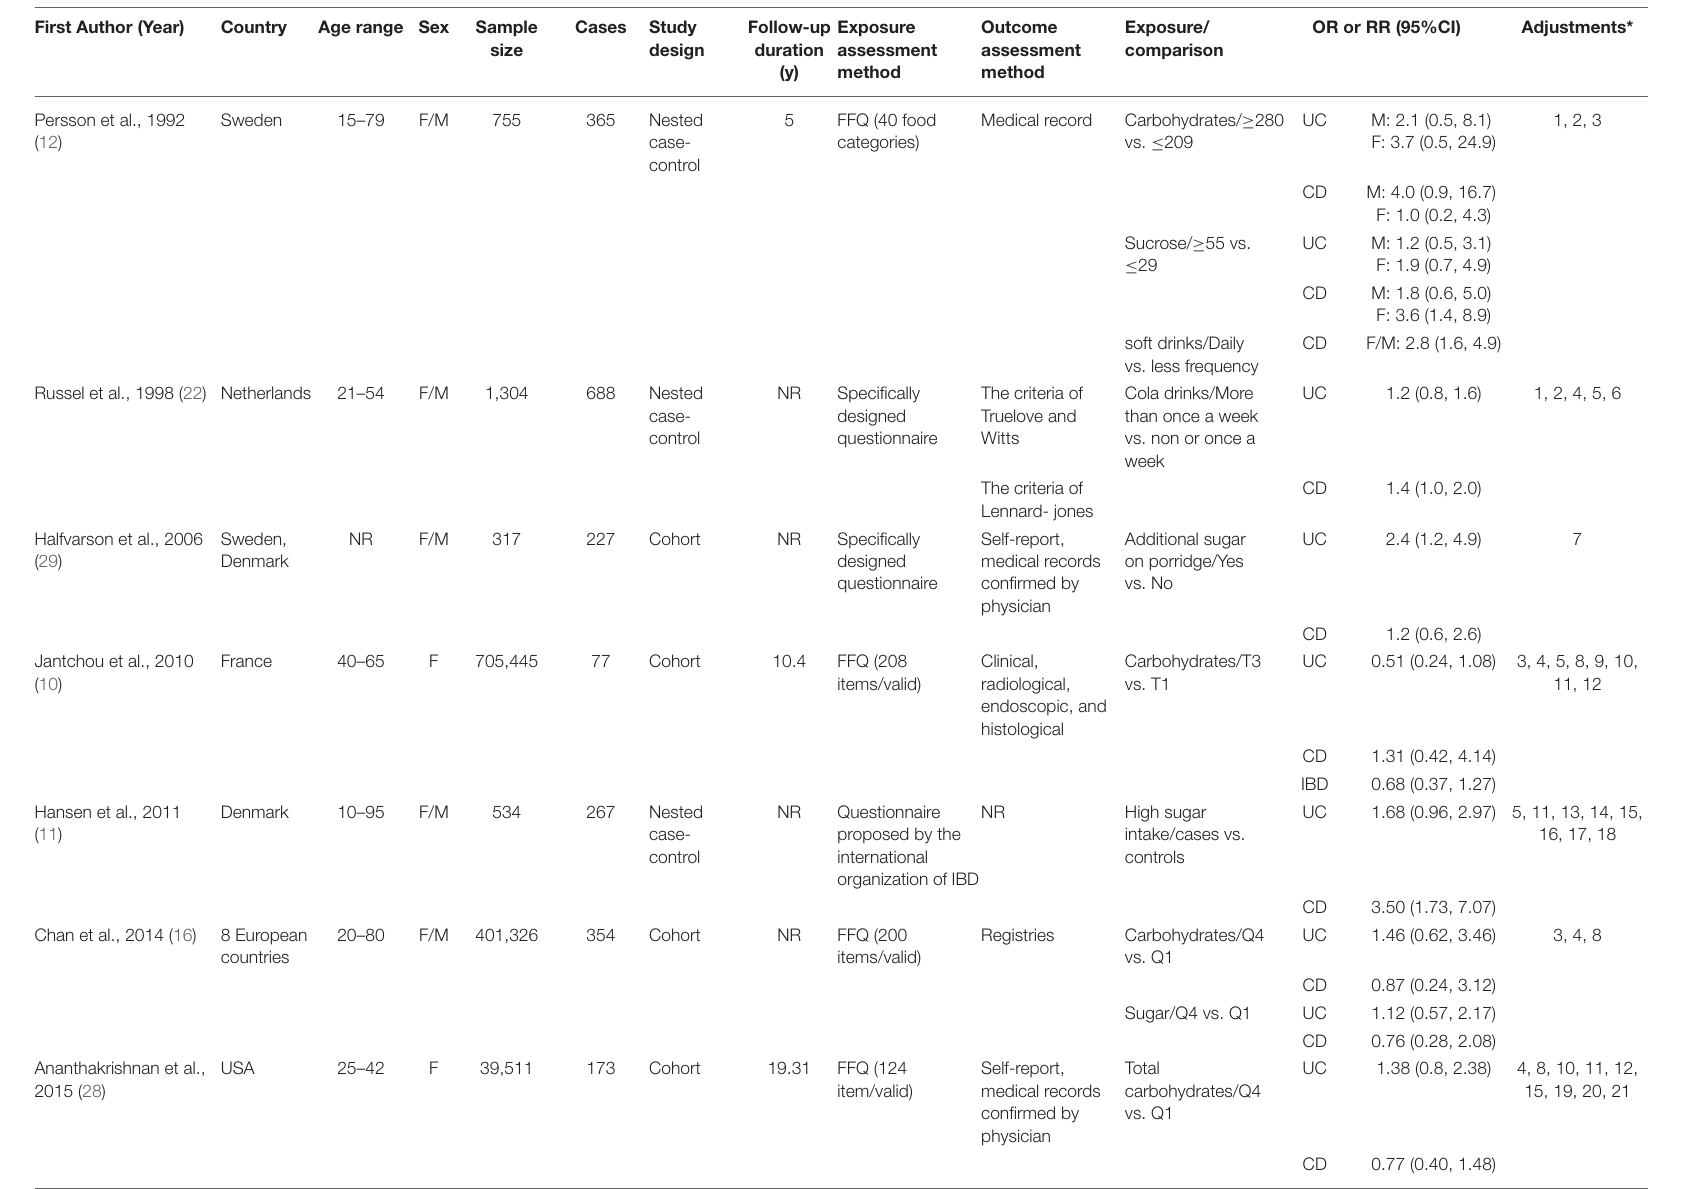
TABLE 1 | General characteristics of included